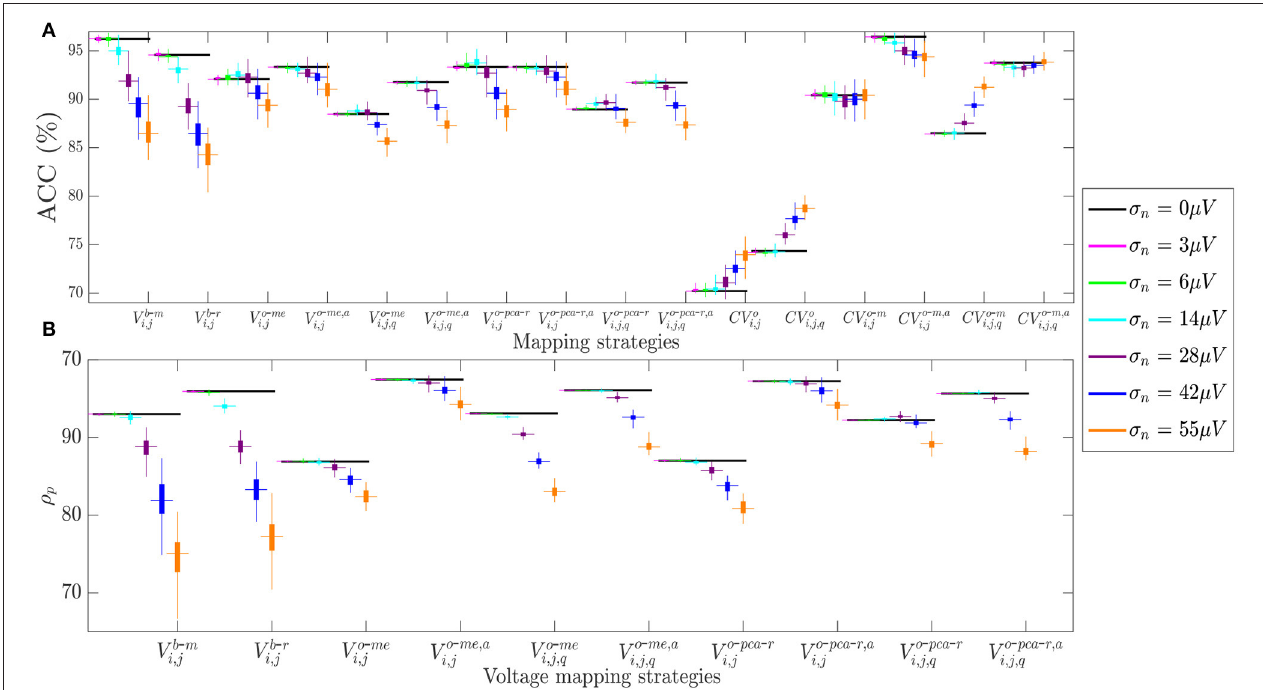
FIGURE 9 | (A) Fibrosis detection accuracy (ACC) of the different mapping strategies. (B) Pearson’s correlation coefficient ρ p of the different voltage mapping strategies. For each noise level, the central mark and the bottom and top edges of each box indicate the median, the first and the third quartile, respectively, whereas the noise-free ACC and ρ p are depicted as black horizontal